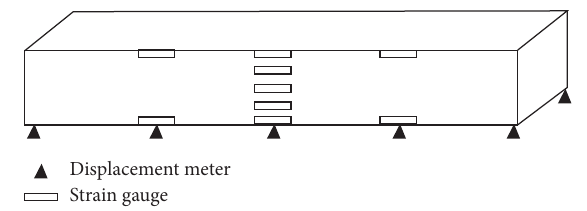
Figure 7: Layout of strain gauges and displacement meters.